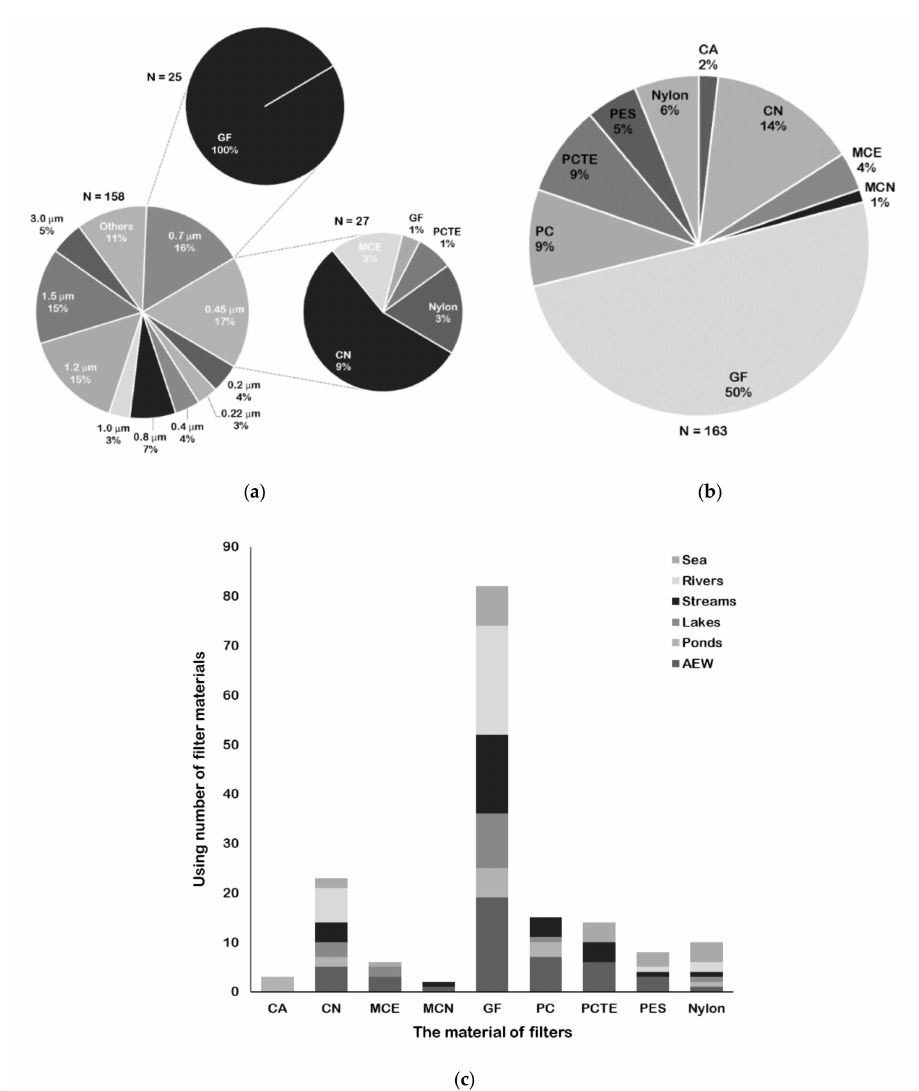
Figure 1. Various pore sizes and materials for filter types used for fish eDNA capture. ( a ) Percentage of pore size and two main pore sizes corresponding material of filters used in water